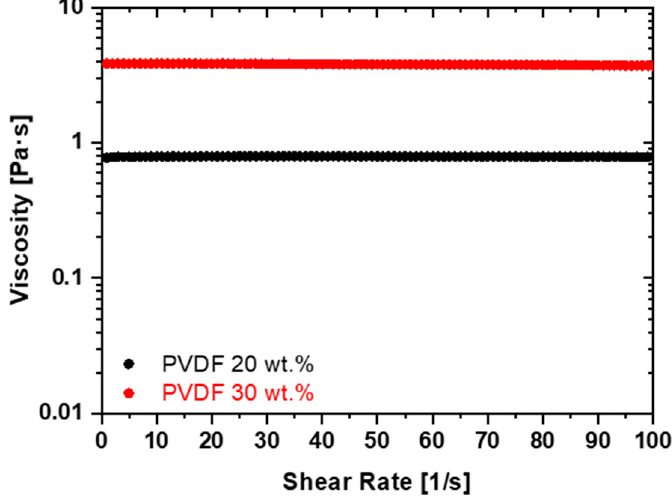
Figure 1. Viscosity curves of PVDF / DMF (N,N dimethylformamide) solutions with di ff erent polymer